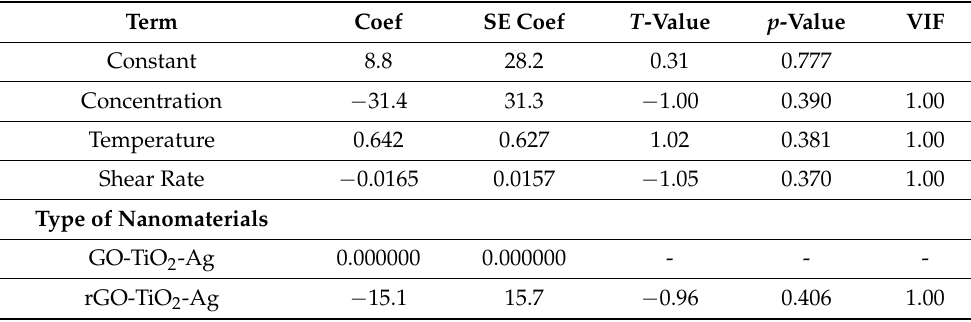
Table 6. Coefficient table